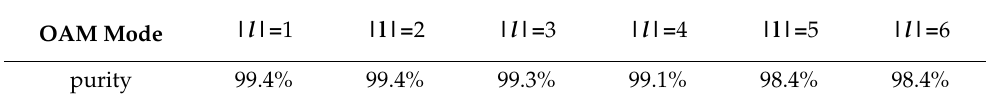
Table 1. OAM mode purity ( | l | = 1 ∼ 6).